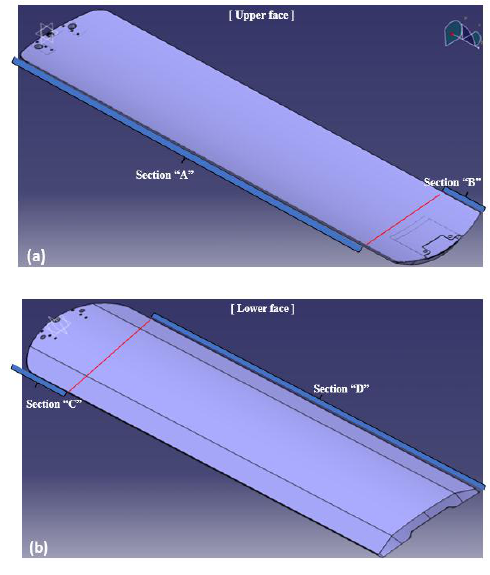
Materials 2019 , 12 , x FOR PEER REVIEW Figure 8. Proposed Sequence pattern; ( a ) Upper face ( b ) Lower face. Figure 8. Proposed Sequence pattern; ( a ) Upper face ( b ) Lower face.